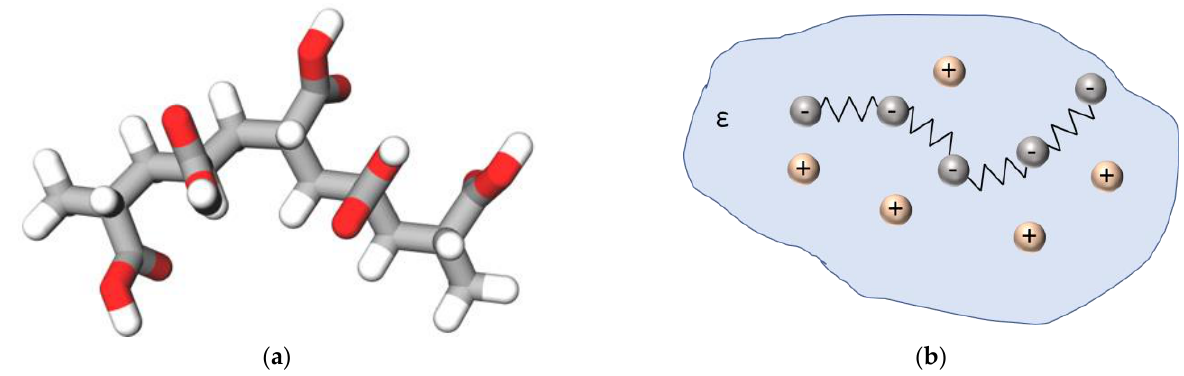
Figure 6. ( a ) Atomistic representation of polyacrylic acid and ( b ) its coarse-grained model.